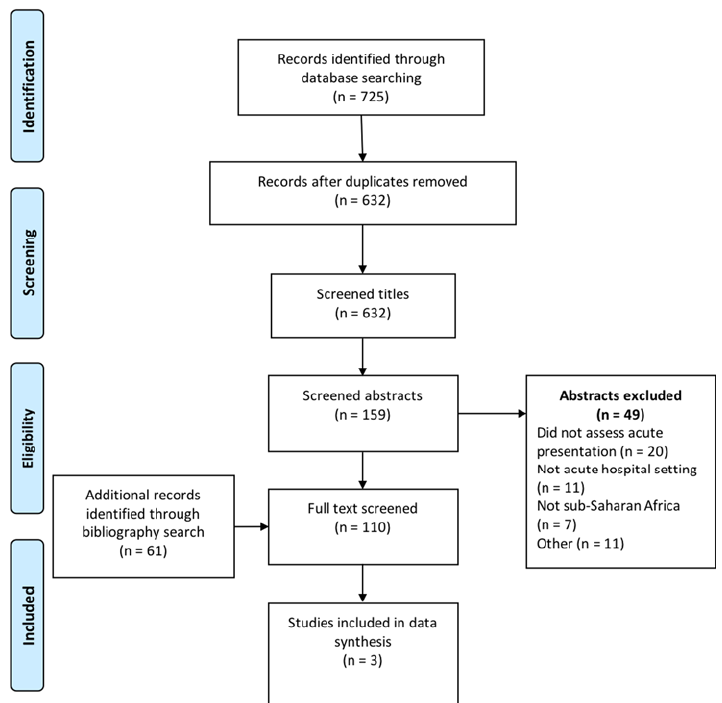
Figure 1. PRISMA flow diagram. PRISMA: Preferred Reporting Items for Systematic Reviews and Meta ‐ Analyses.